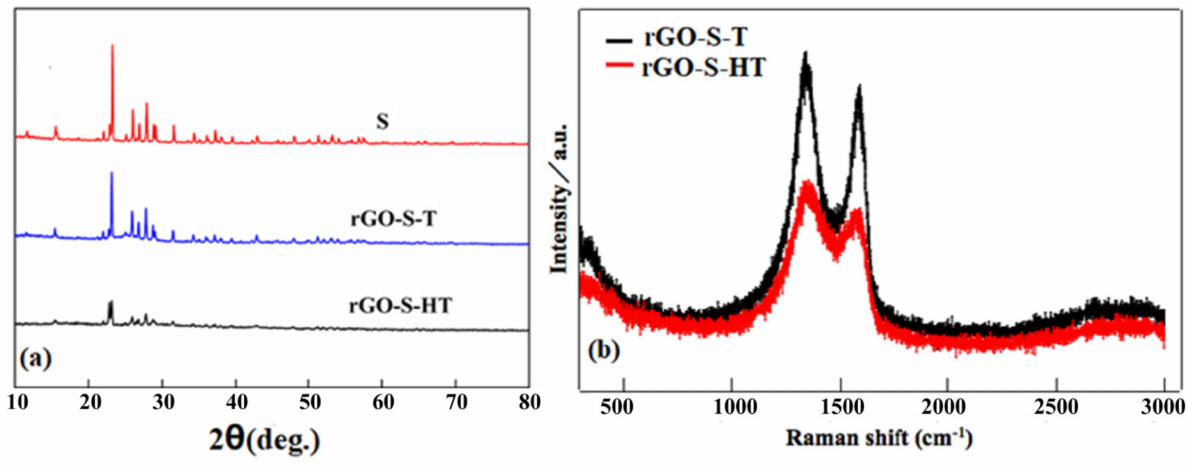
Figure 2. ( a ) XRD patterns of S, reduced graphene oxide-sulfur by in-situ thermal reduction (rGO-S-T) and rGO-S-HT (by hydrothermal method) samples, ( b ) Raman spectra of rGO-S-T and rGO-S-HT